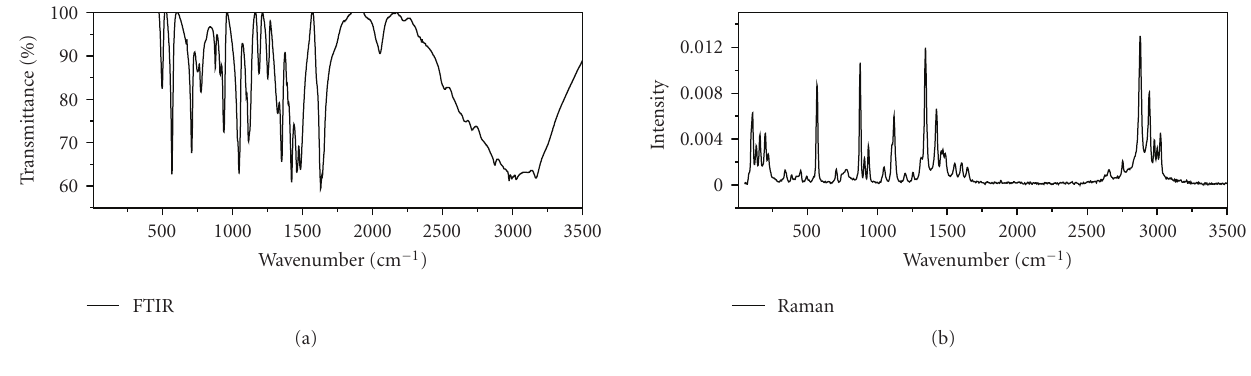
Figure 17: FTIR and FT-Raman spectra of L-threonine.